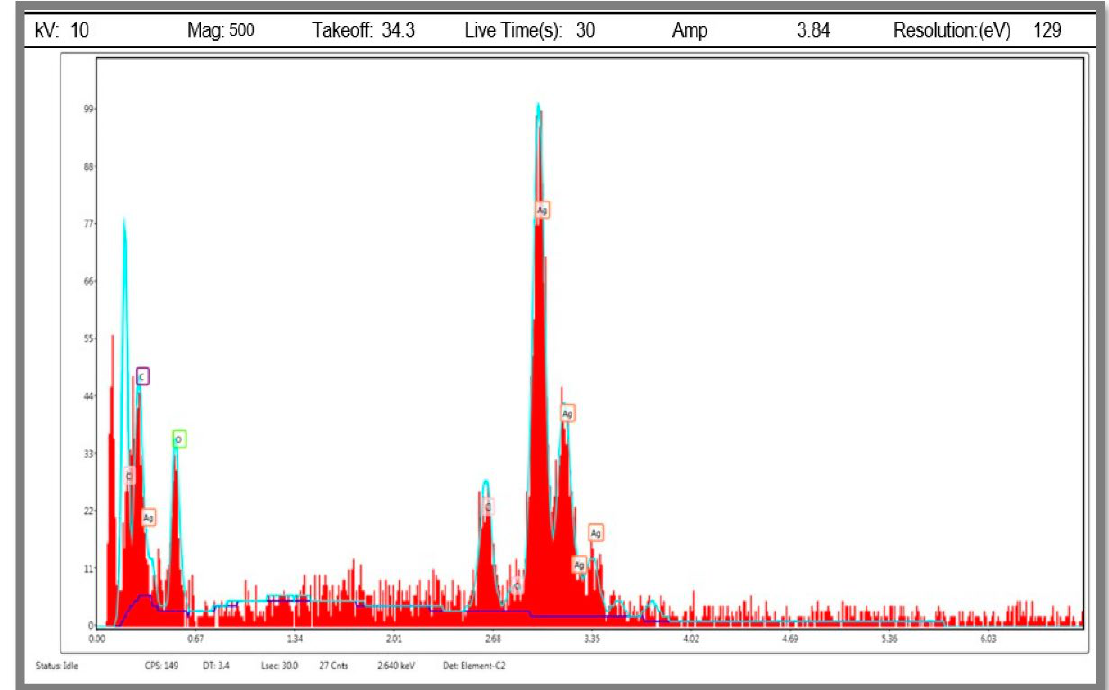
Figure 6. The EDX spectrum of silver nanoparticles (BP-AgNPs) depicts an Ag peak between 2–3 KeV. Table 1. Elemental composition of synthesized silver nanoparticles. Element